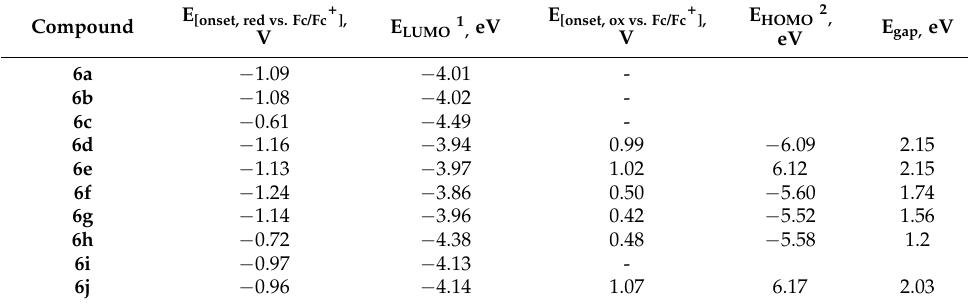
Table 5. Electrochemical data for compounds 6a – j in CH 2 Cl 2 .